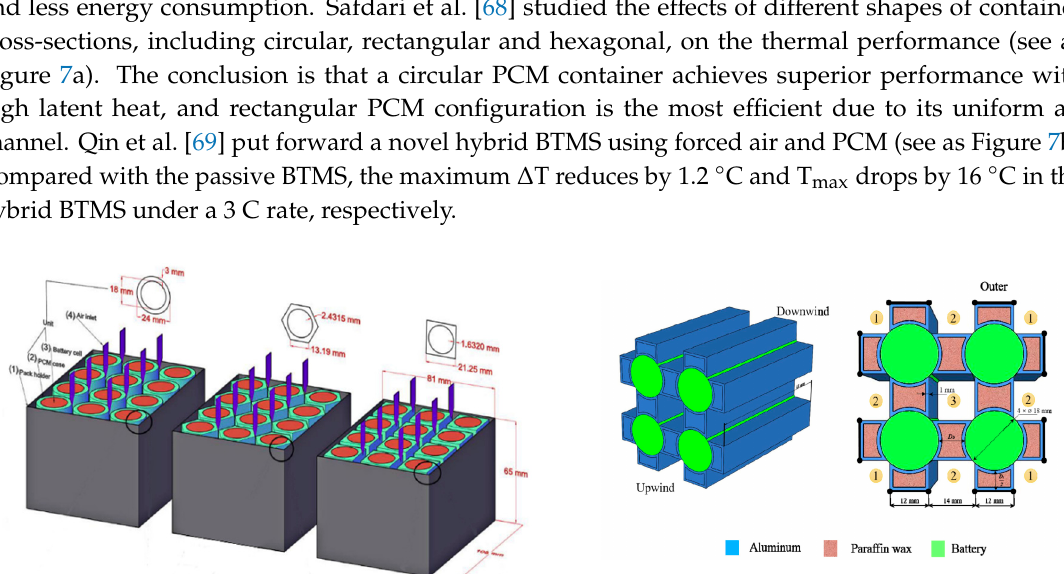
Figure 6. Classic structures of hybrid BTMS combining PCM with air or liquid active cooling method. ( a ) Combination of phase change slurry and mini channel liquid cold plate (LCP). Reprint